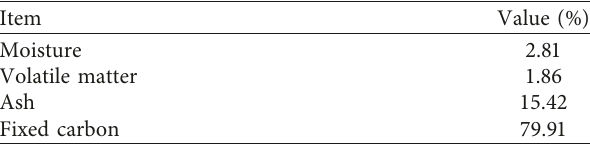
Table 1: Proximate analysis of waste